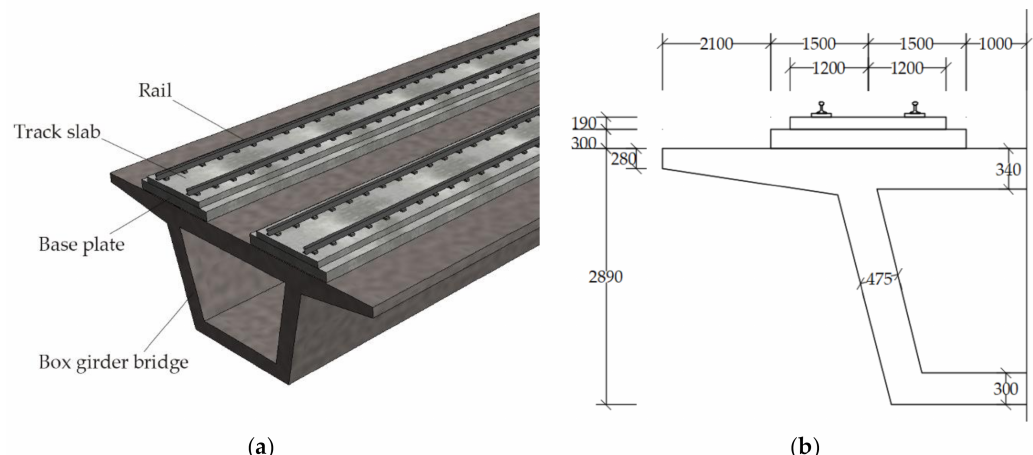
Figure 2. Typical section of the China Railway Track System I type slab track on the bridge: ( a ) schematic diagram of the solid section; ( b ) section size of one side of the structure of the symmetry axis (unit: